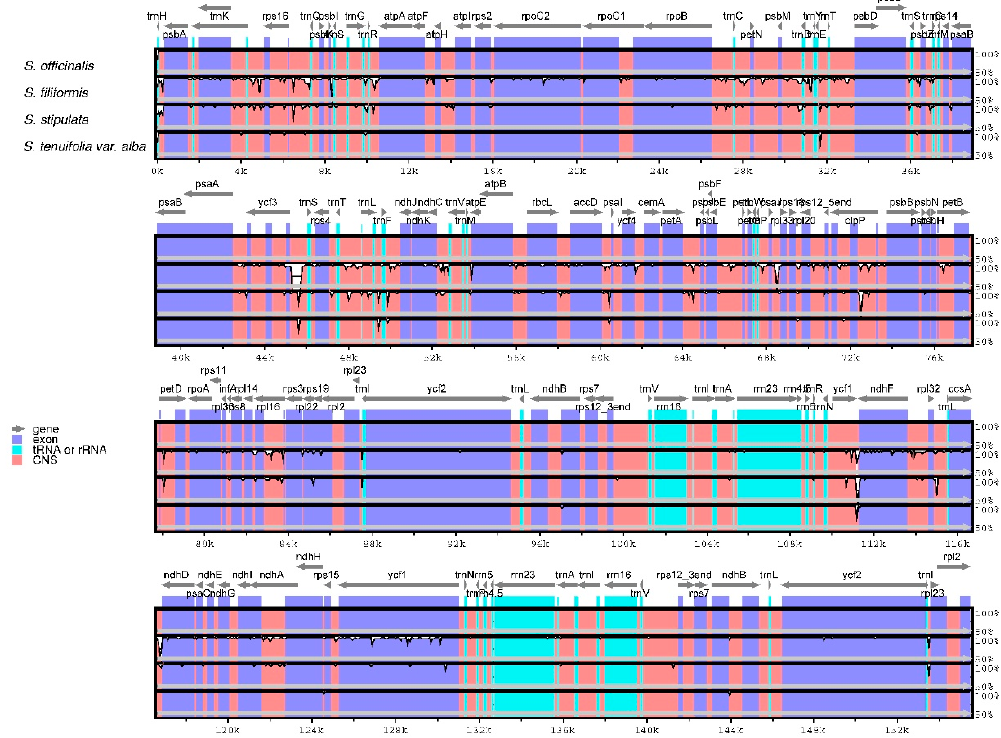
Figure 3. Comparison of the four Sanguisorba chloroplast genomes using mVISTA. CNS indicates conserved noncoding sequences. The Y-scale represents the percent identity between 50% and 100%.